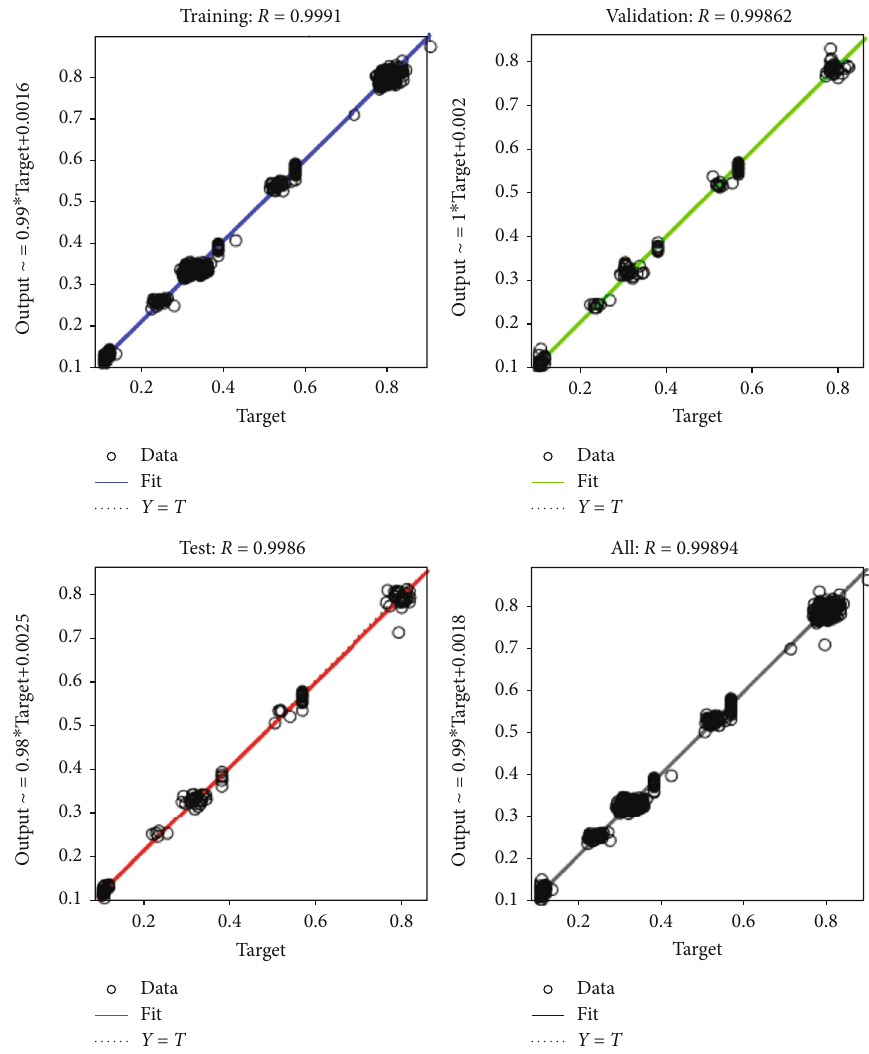
Figure 3: Regression